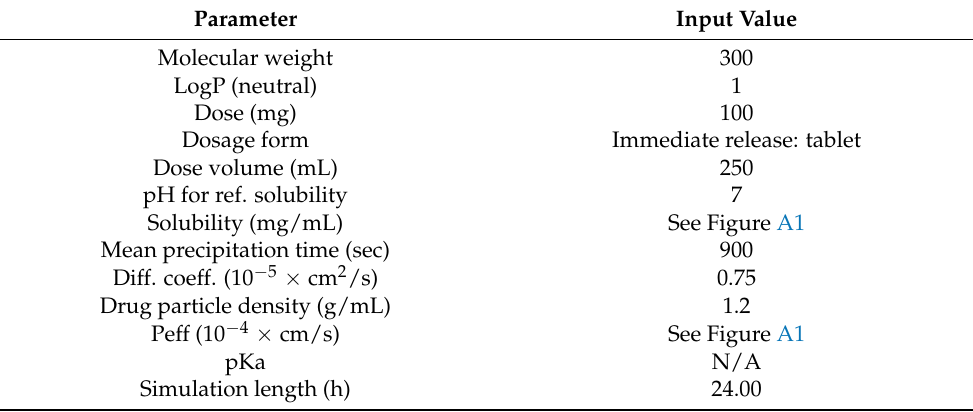
Table A1. Input parameters of the PBPK